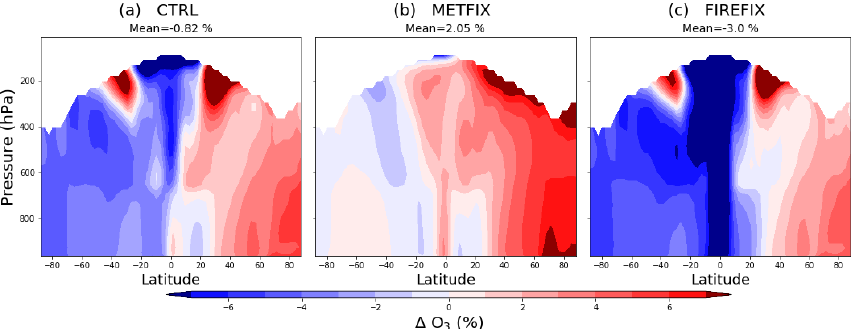
Figure 9. Latitude–pressure cross sections of the percentage difference in O 3 concentrations during the 1997 El Niño event compared to 1997–2014 period mean for the TOMCAT simulations: (a) CTRL, (b) METFIX and (c) FIREFIX